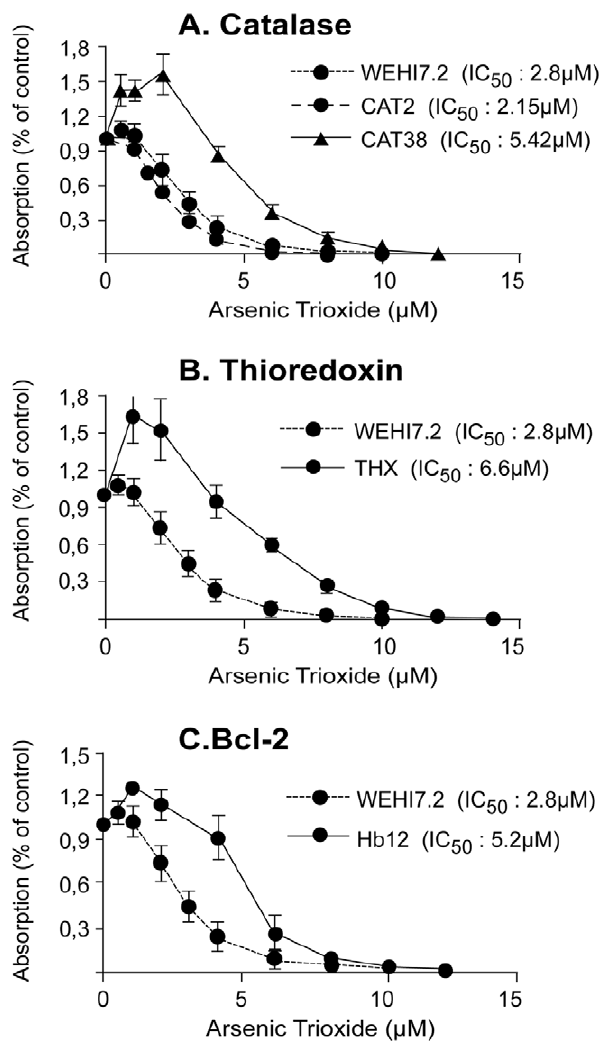
Figure 5. Cytotoxicity of arsenic trioxide on WEHI7.2 cell lines. Cells stably transfected with expression vectors carrying cDNAs for (A) catalase, (B) thioredoxin, or (C) Bcl-2, and with mock control vector. Values represent the mean ( 6 SEM) of three independent experiments.